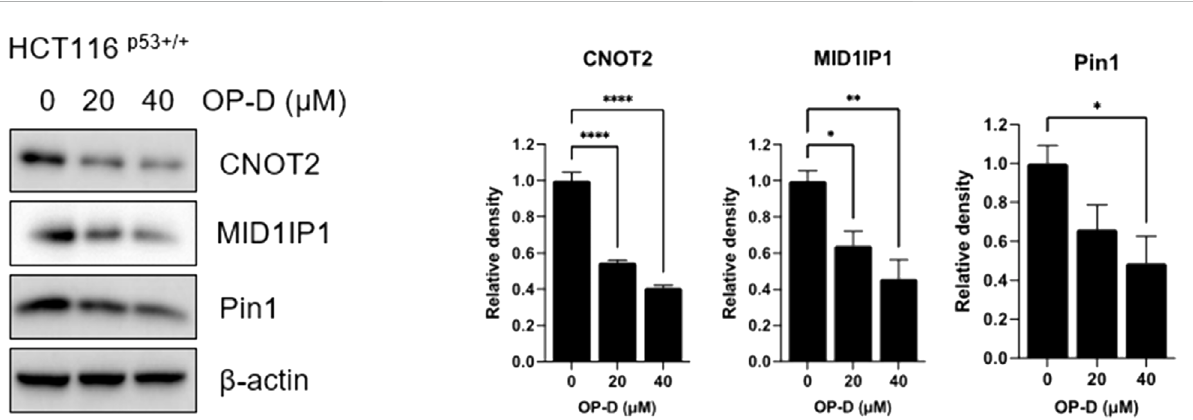
FIGURE 6 OP-D inhibited c-Myc expression in HCT116 p53+/+ cells. HCT116 p53+/+ cells were treated with OP-D (0, 20, or 40 μ M) for 24 h. Cell lysates were performed for CNOT2, MID1IP1, Pin1 and β -actin by Western blotting. Data represent means ± SD. * p < 0.05, ** p < 0.01, **** p < 0.001 versus untreated control. versus untreated control.